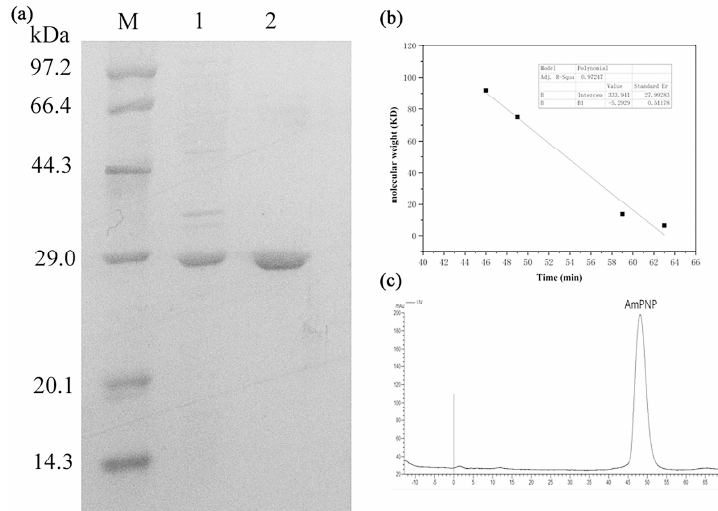
Figure 2. Molecular weight analysis of Am PNP. ( a ) Dodecyl sulfate-polyacrylamide gel electrophoresis (SDS-PAGE) analysis of purified Am PNP. Lane M: marker; Lane 1: crude enzymes;